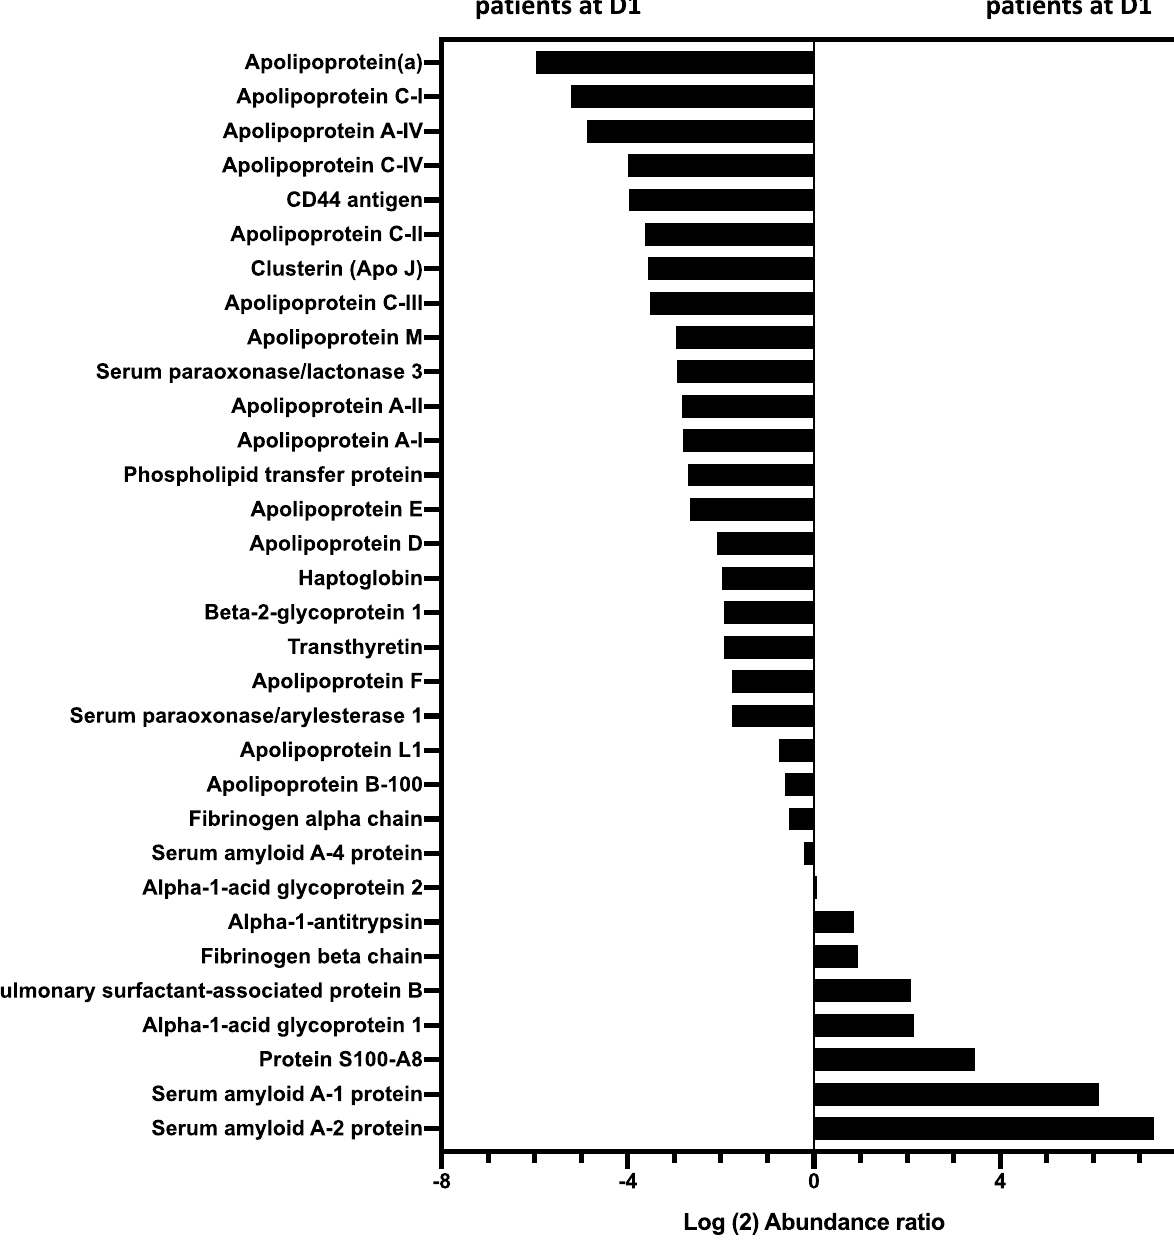
Figure 1. Relative abundance of proteins identified in HDLs isolated from of the plasma of control subjects (n = 15) and COVID-19 patients (n = 8) at admission in ICU (D1). The relative abundance of proteins in HDLs from controls and D1 COVID-19 patients was expressed as the Log2 Abundance ratio (D1 COVID/Control), as described in the “Methods”